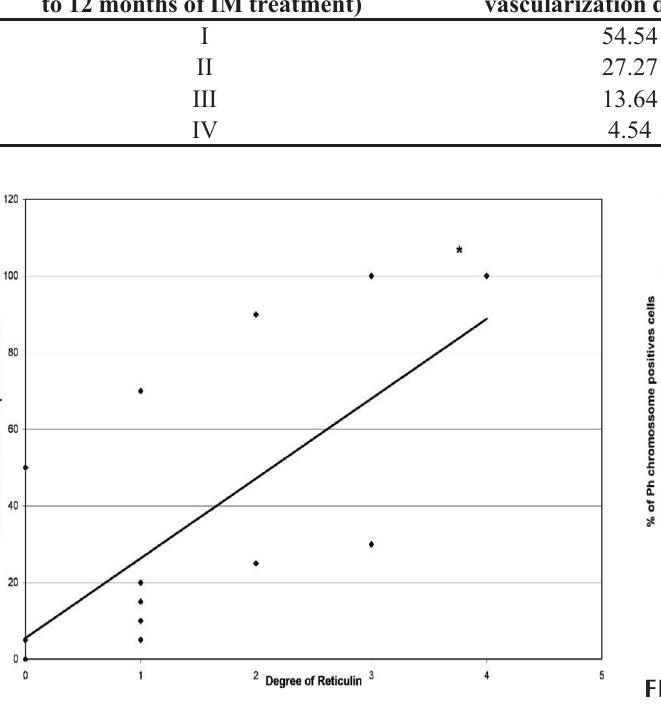
FIGURE 6 - Distribution of patients according to reticulin degree on second BMB and percentage of Ph 1 chromosome positive cells obtained in first cytogenetic examination performed after treatment with IM. Points below the line represent patients who achieved CR, while points above the line represent non- responders. This graph was constructed assuming a cytogenetic response occurs when there is less than 35% Ph 1 chromosome positive cells on the cytogenetic test (Major Cytogenetic Response). noting the percentage of chromosome Ph 1 positive cells and vascularization degree of BMB collected after treatment. Points below the line represent patients who achieved CR and points above the line represent patients who did not